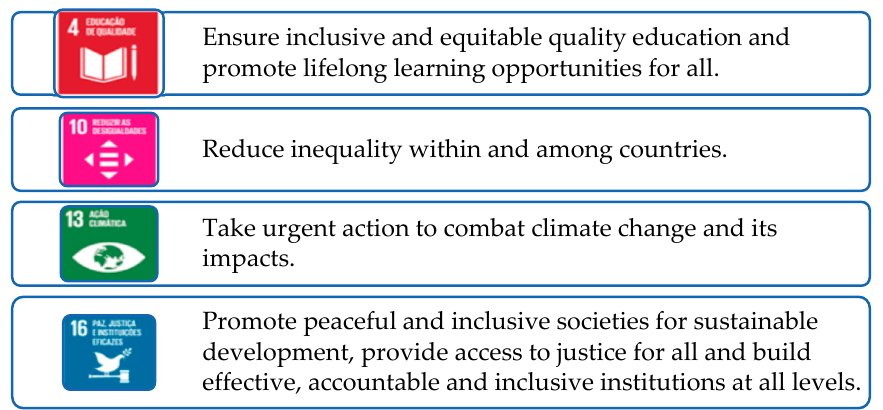
Figure 1. Definitions of SDGs 4, 10, 13, and 16. Source: adapted from https://sdgs.un.org/goals (accessed on 13 February 2023).